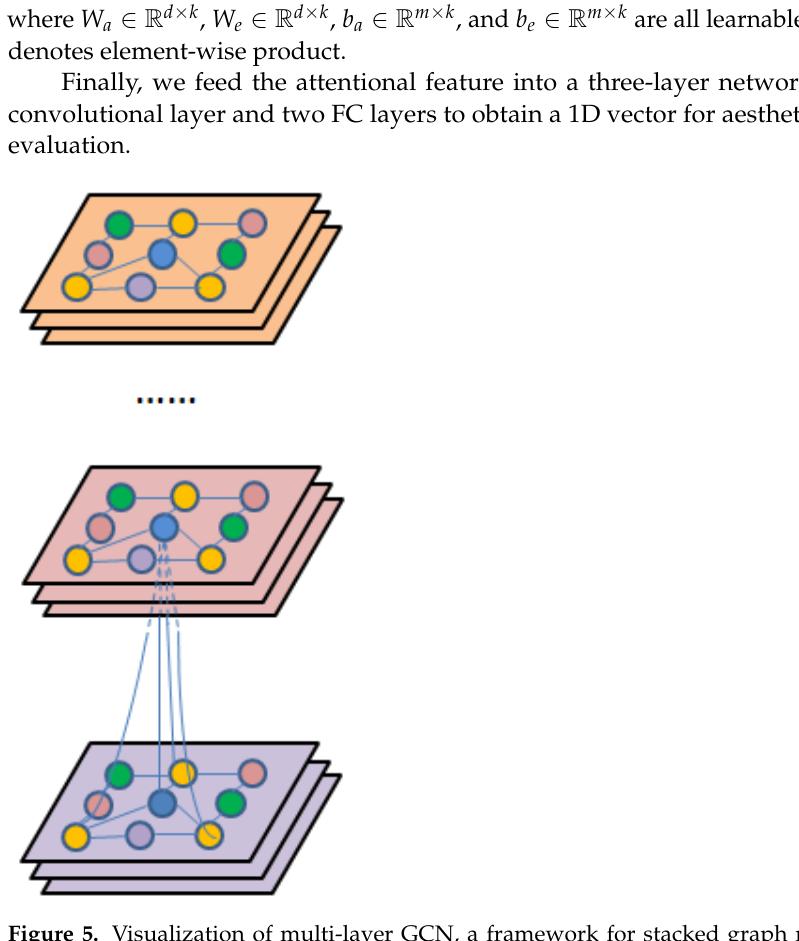
Figure 5. Visualization of multi-layer GCN, a framework for stacked graph reasoning with the regional map based on relationships between nodes. Nodes with different semantic labels are marked with different colors, and edges denote multimodal relationships between nodes. Each node feature is gradually updated only by itself and the nodes with edges connected to